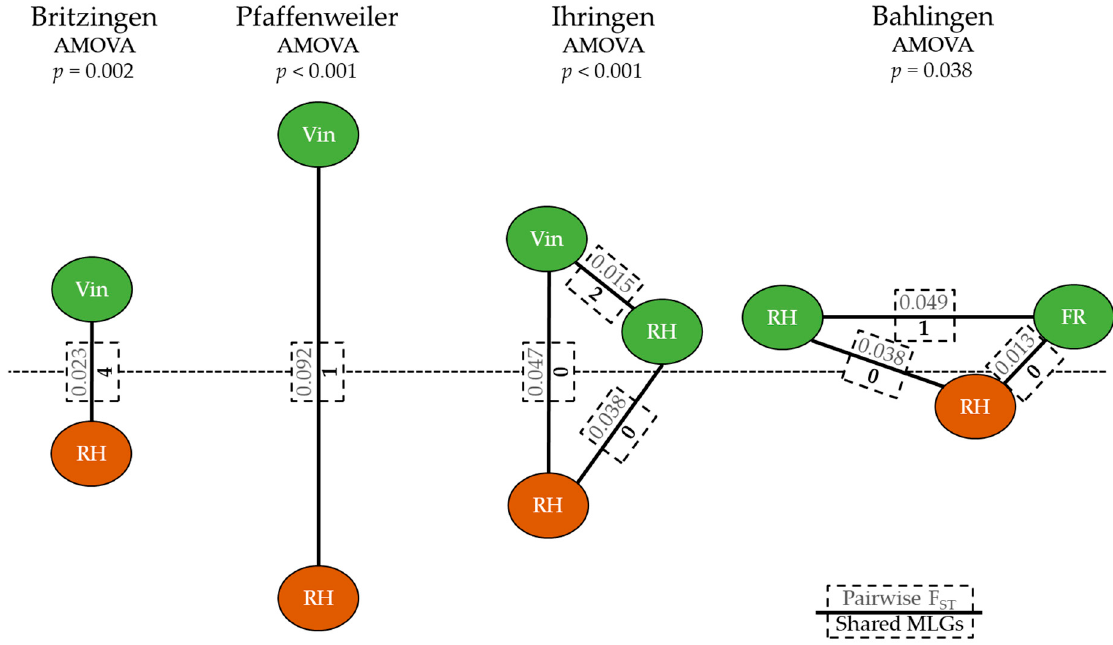
Figure 2. AMOVA p -values, pairwise F ST , and shared MLGs. Green and brown spheres represent phylloxera leaf and root populations sampled in 2018 from V. vinifera (Vin), fungus-resistant varieties (FR), and rootstock hybrids (RH). Lines indicate relative F ST distances between the populations.